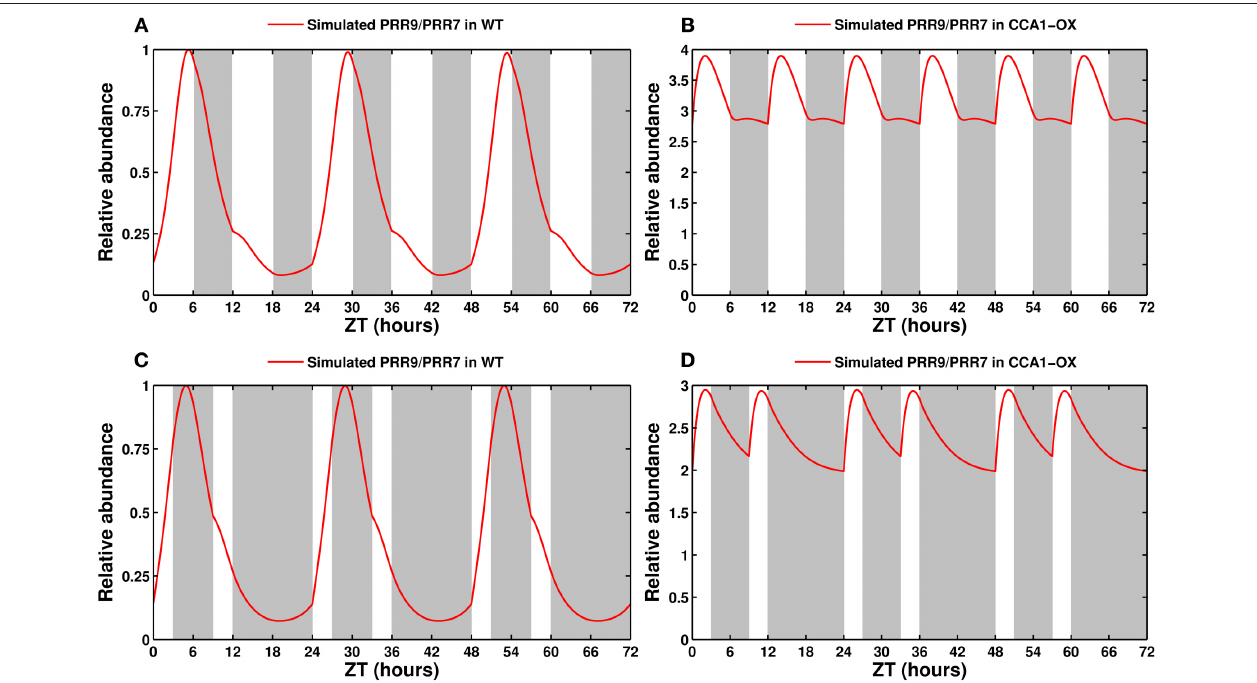
FIGURE 8 | Entrainment by non-24 h cycles and skeleton photoperiods. (A) Entrainment of the wild type clock by a 12 h cycle (6L:6D). The clock oscillates with a 24 h, not 12 h, period. (B) Response of a CCA1-overexpressing line in a 12 h cycle. This arrhythmic line entrains to the short cycle. (C) Entrainment of the wild type clock by a skeleton photoperiod (3L:6D:3L:12D). The functional clock entrains to the 24 h cycle. (D) Response of the CCA1-OX line to a skeleton